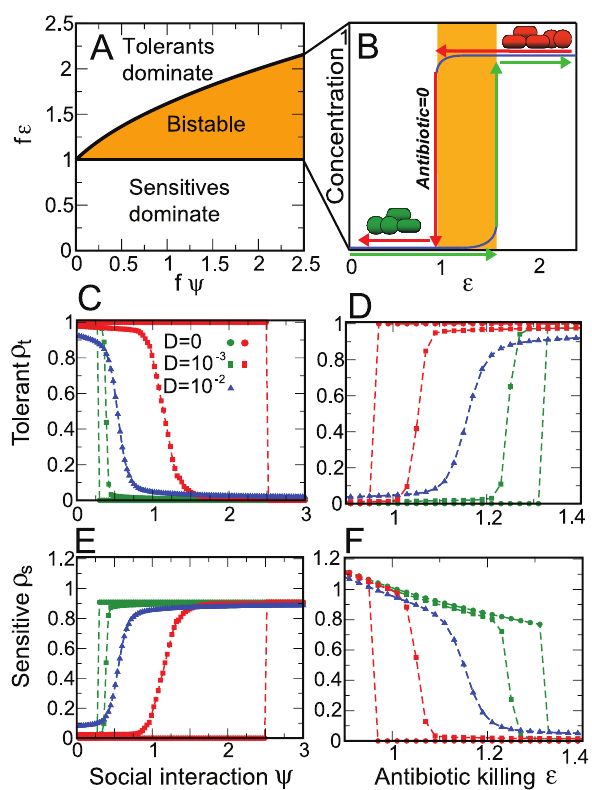
Figure 2. Multistability and hysteresis in a simple model of the intestinal microbiota. A: phase diagram showing the three possible stability regions. Antibiotic-sensitive bacteria dominate when f E v 1 and antibiotic-tolerant bacteria dominate when f E w 1 = 2 z ffiffiffiffiffiffiffiffiffiffiffiffiffiffiffiffiffiffiffiffiffi 1 z 4 f y = 2